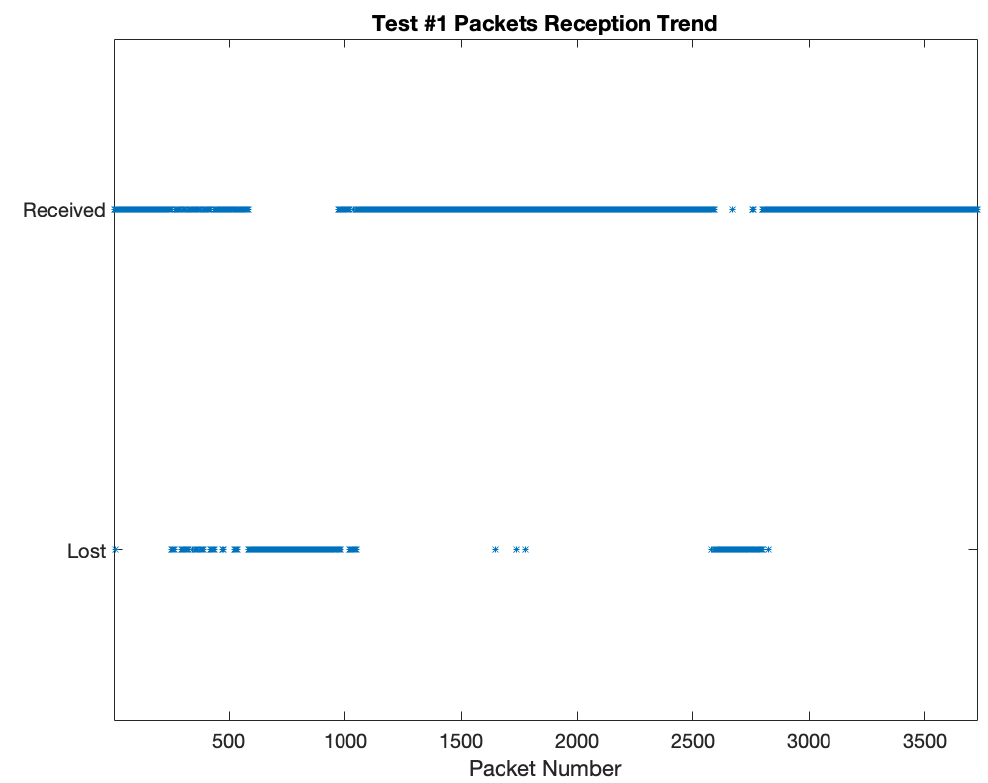
Figure 7. Test #1